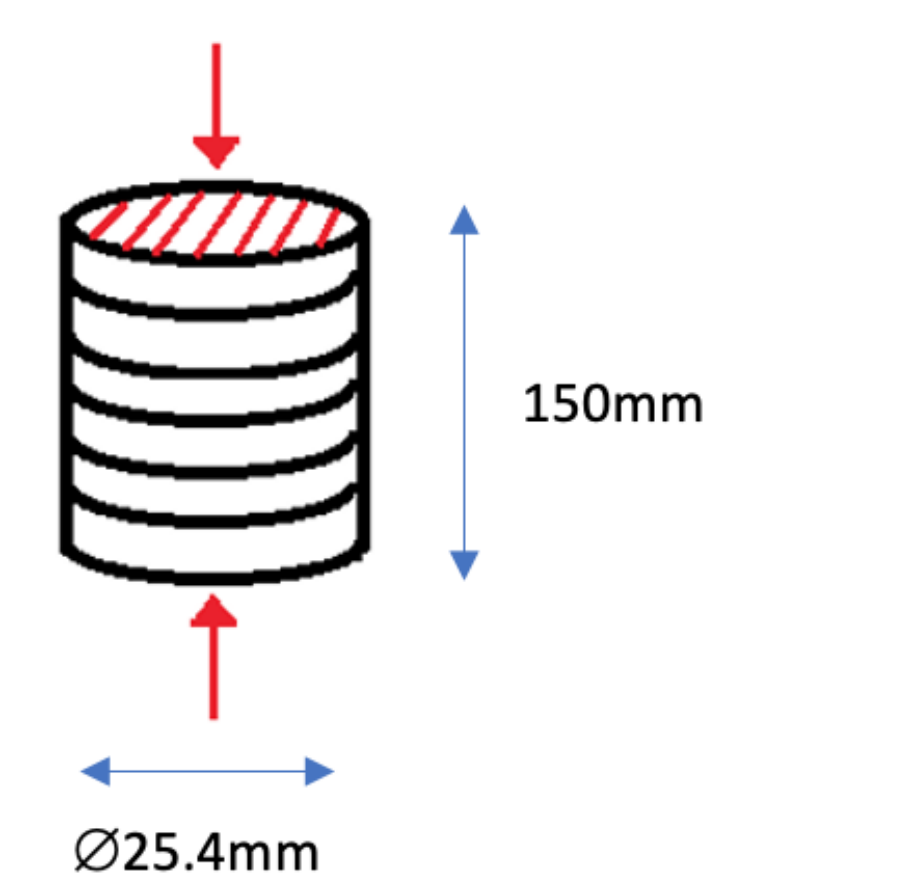
Figure 3. Schematic diagram of testing pipe sample on vertical position.